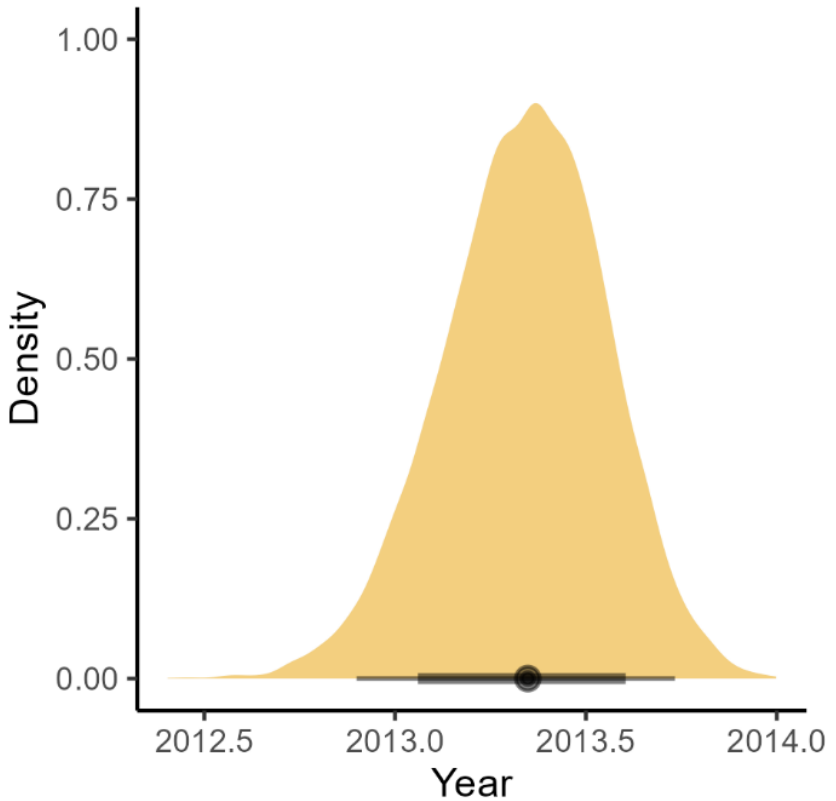
Figure 4. Density plot of the estimated age of the root of the RHDV2 phylogenetic tree based on the Bayesian Skyline Plot analysis. The dot on the black bar shows the posterior median, the thick bar the 80%, and the thin bar the 95% credible intervals.